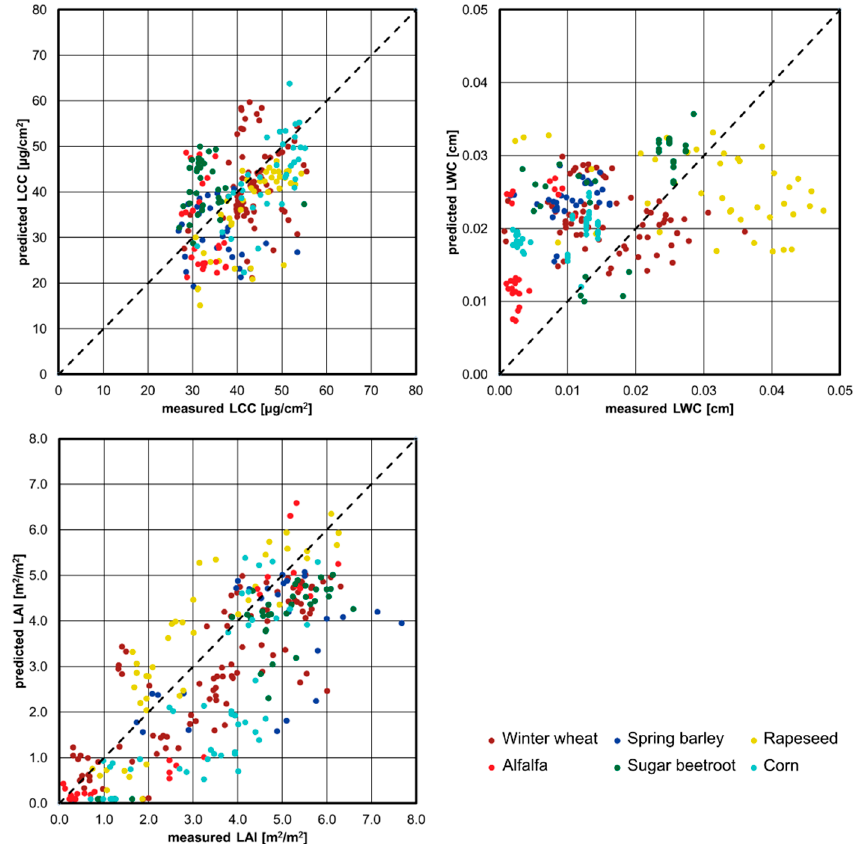
Figure 10. Scatter plots for biophysical parameters LAI, LCC, and LWC retrieved and measured in situ (validation data subset).